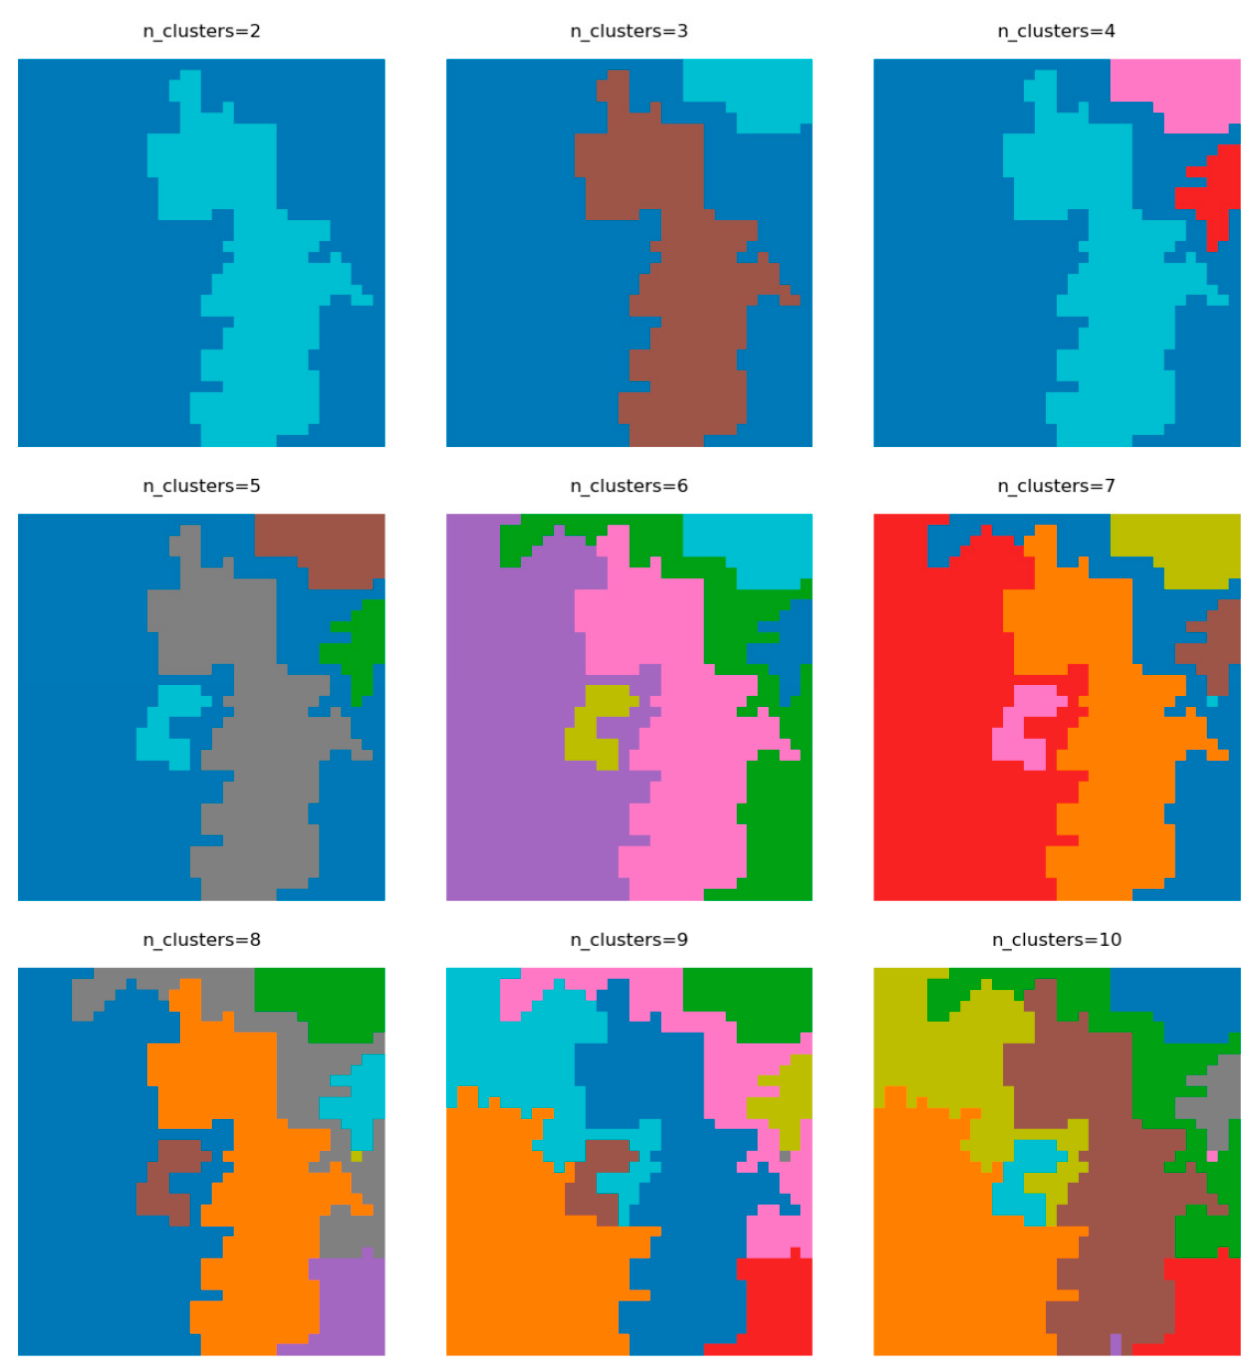
Figure 8. Agglomerative clustering of 72961_840430_M-34-40-B-a-2-3 sample encoded patches using different cluster numbers.